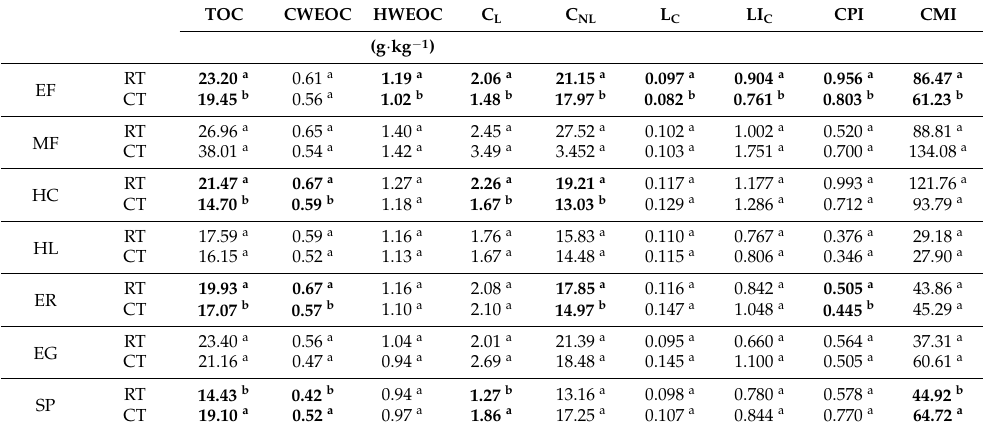
Table 5. Differences in the parameters of different soils and tillage. TOC CWEOC HWEOC C L C NL L